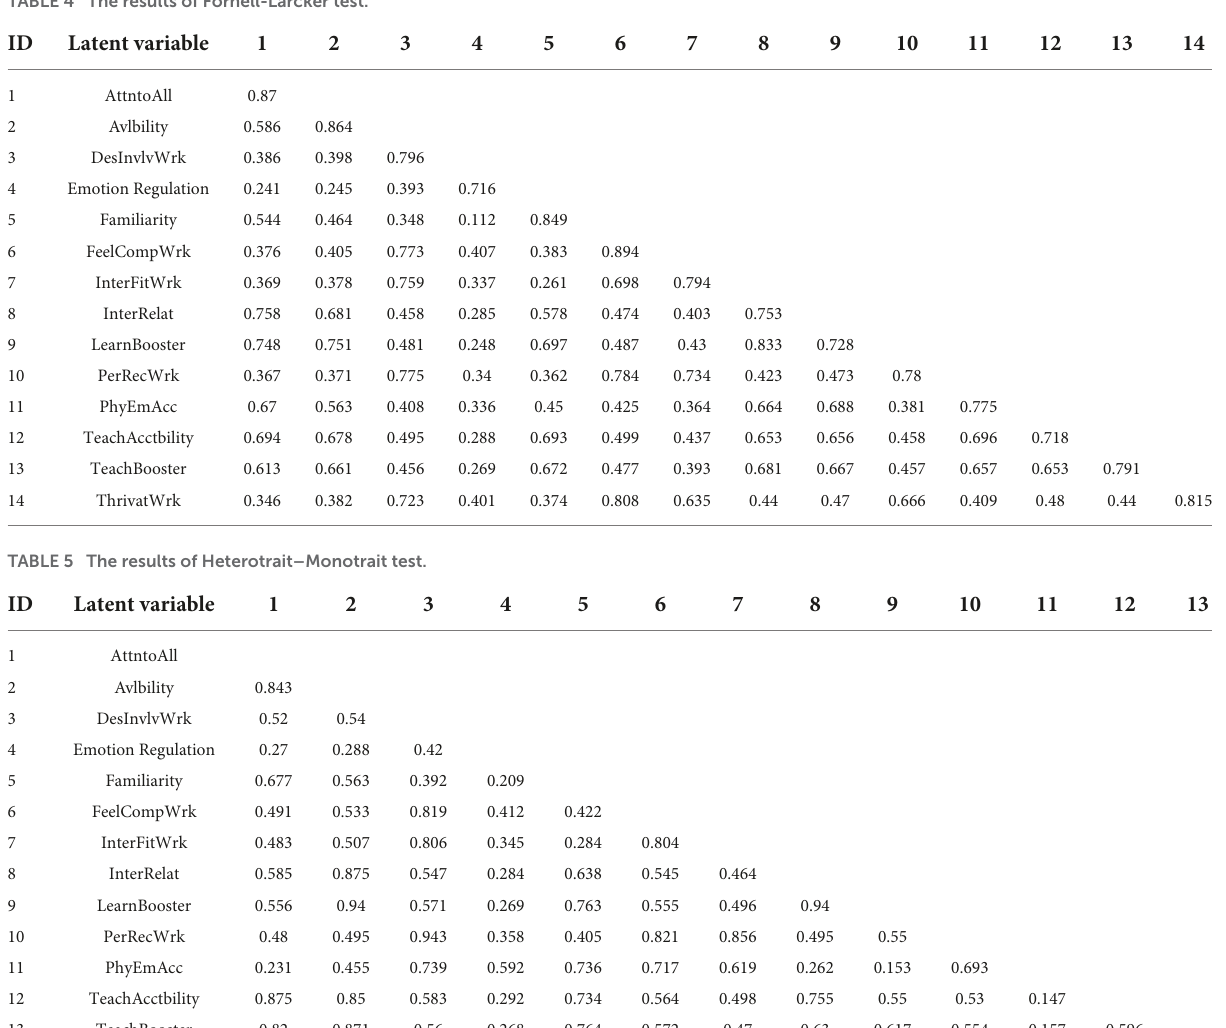
TABLE 4 The results of Fornell-Larcker test.